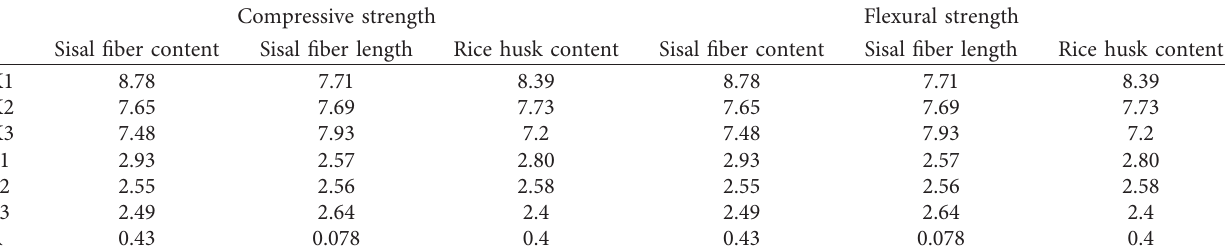
Table 5: k value of compressive strength and flexural strength.